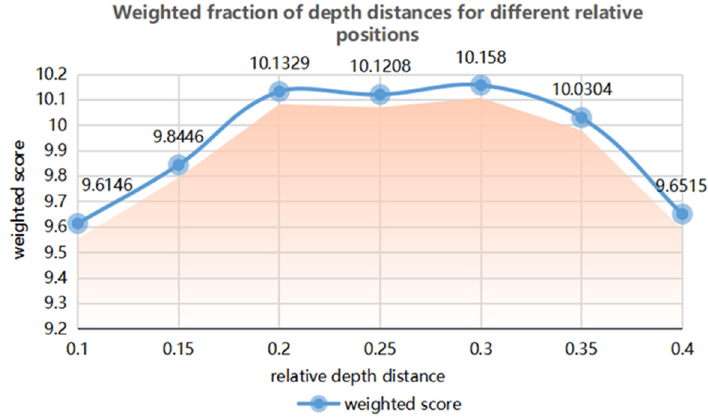
Figure 19. Trend of the weighted scores of the depth distances for different relative positions.